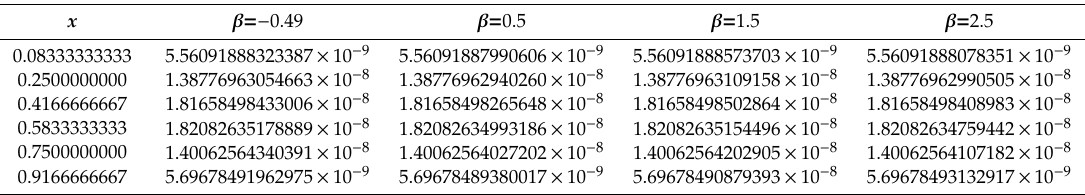
Table 1. For λ = 0.005 and α = 0.75, the maximum error of example with the Gegenbauer wavelet collocation method for various values of β .